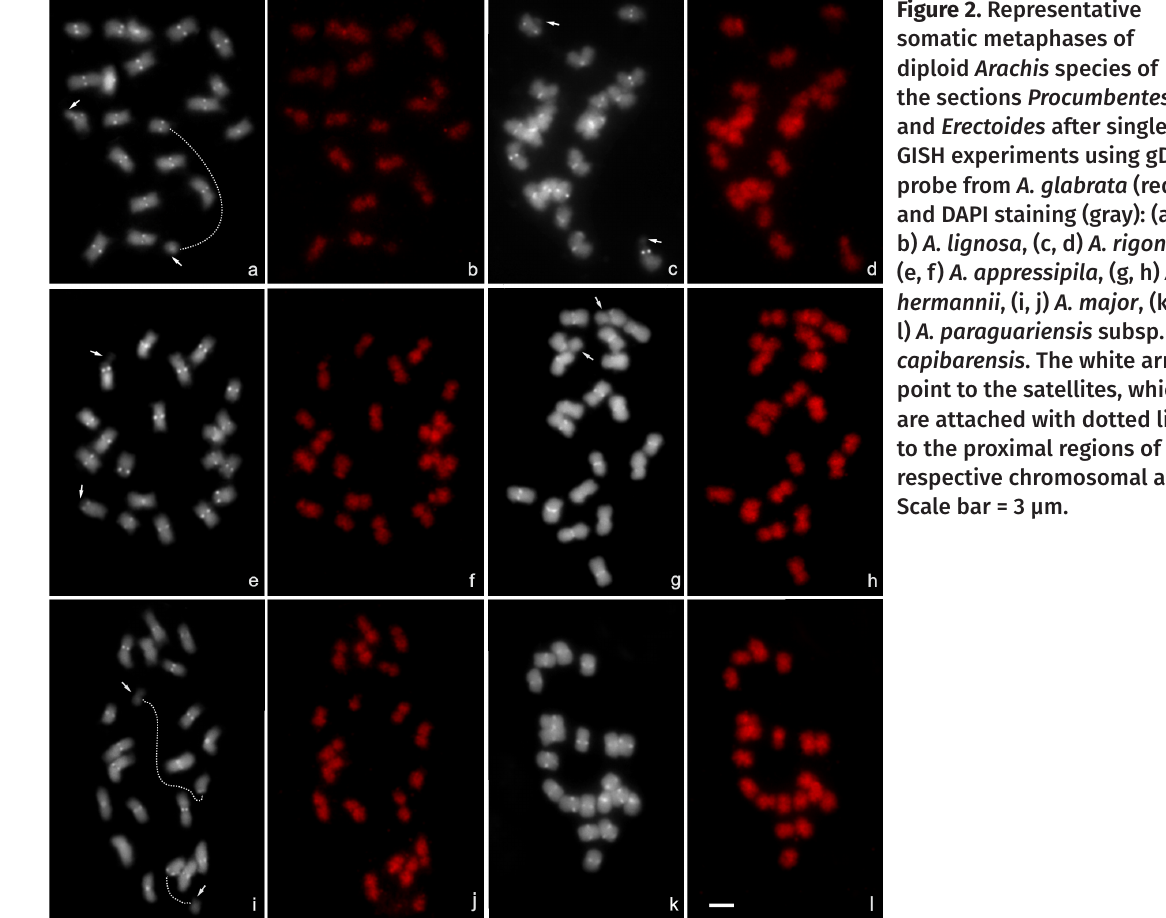
Figure 2. Representative somatic metaphases of diploid Arachis species of the sections Procumbentes and Erectoides after single GISH experiments using gDNA probe from A. glabrata (red) and DAPI staining (gray): (a, b) A. lignosa , (c, d) A. rigonii , (e, f) A. appressipila , (g, h) A. hermannii , (i, j) A. major , (k, l) A. paraguariensis subsp. capibarensis . The white arrows point to the satellites, which are attached with dotted lines to the proximal regions of their respective chromosomal arms. Scale bar = 3